Question: Write a single sentence explaining what this figure depicts.
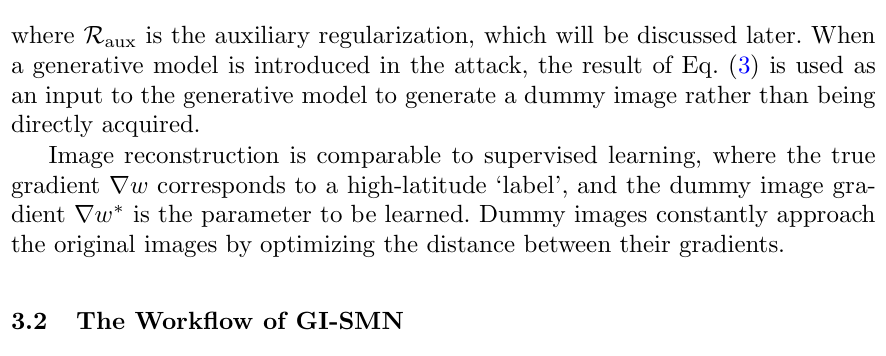
Answer: depicts the main structure of GI-SMN, which comprises image generation, gradient matching, and iterative optimization process. GI-SMN operates in the following steps to successfully reconstruct images from the target FL system. First, a random Gaussian distribution creates latent code fed into the gener- ative model StyleGAN-XL to generate the initial dummy images. Then, the generated dummy images are input into the FL model to get the dummy gra- dients using backpropagation. Meanwhile, the original images are also fed into the FL model to acquire the true gradients. Next, the latent code is optimized